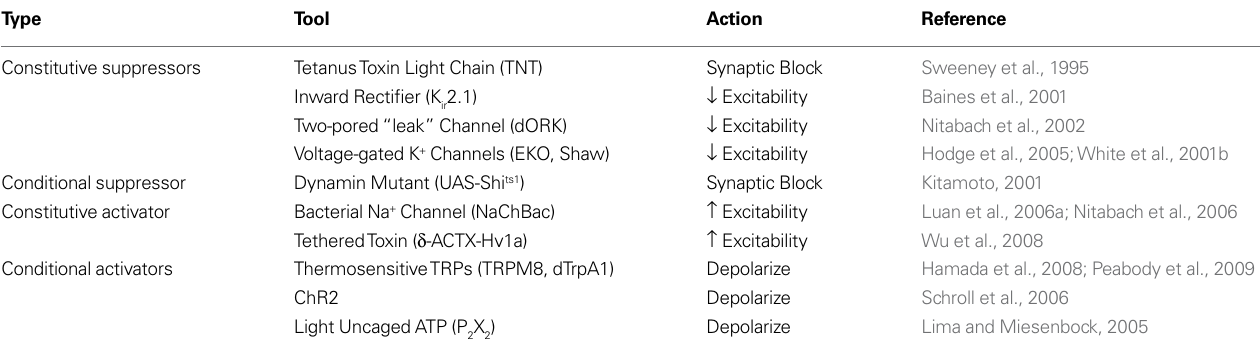
Table 1 | Tools for manipulating neuronal excitability in